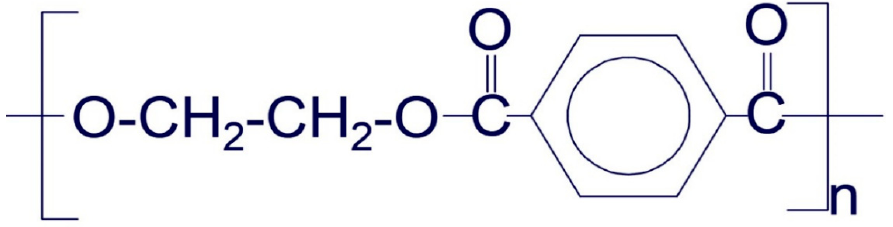
Figure 1. PET stockpile at Mariannhill landfill site in Durban . PET consists of long hydrocarbons chain with carbon, hydrogen, and oxygen (C 10 H 8 O 4 )n as the dominant molecular elements. The molecular bond structure of the PET waste is presented in Figure 2. The chemical constituents of the PET waste were evaluated through an X-ray fluorescence (XRF) test. This test result revealed that the PET waste herein consisted of butylene, ethylene, and propylene with its dry density varying within 910 and 913 kg/m 3 in conformance with ASTM D792 [33] protocol.